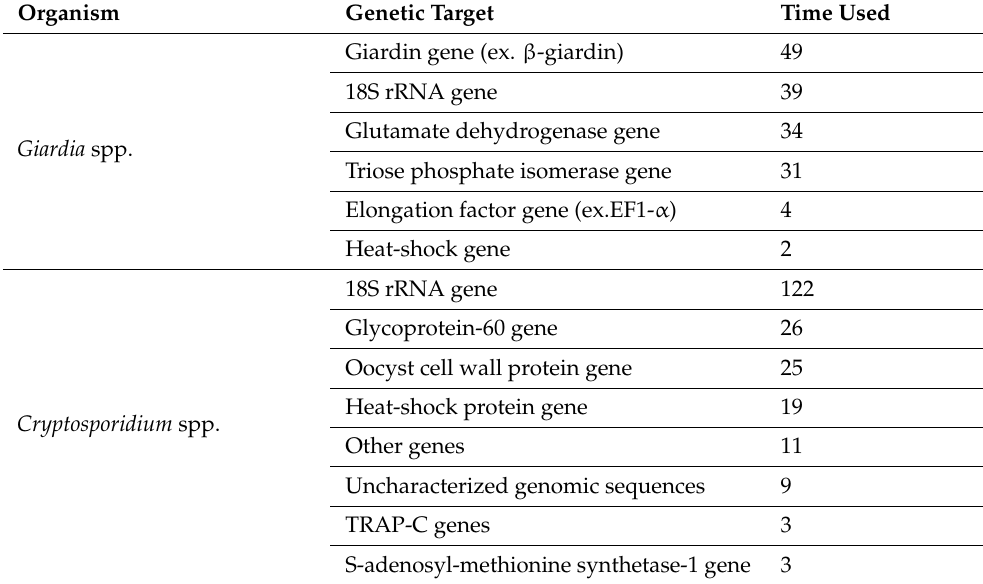
Table 2. Frequency of use of different genetic targets by molecular biology studies. Organism Genetic Target Time Used